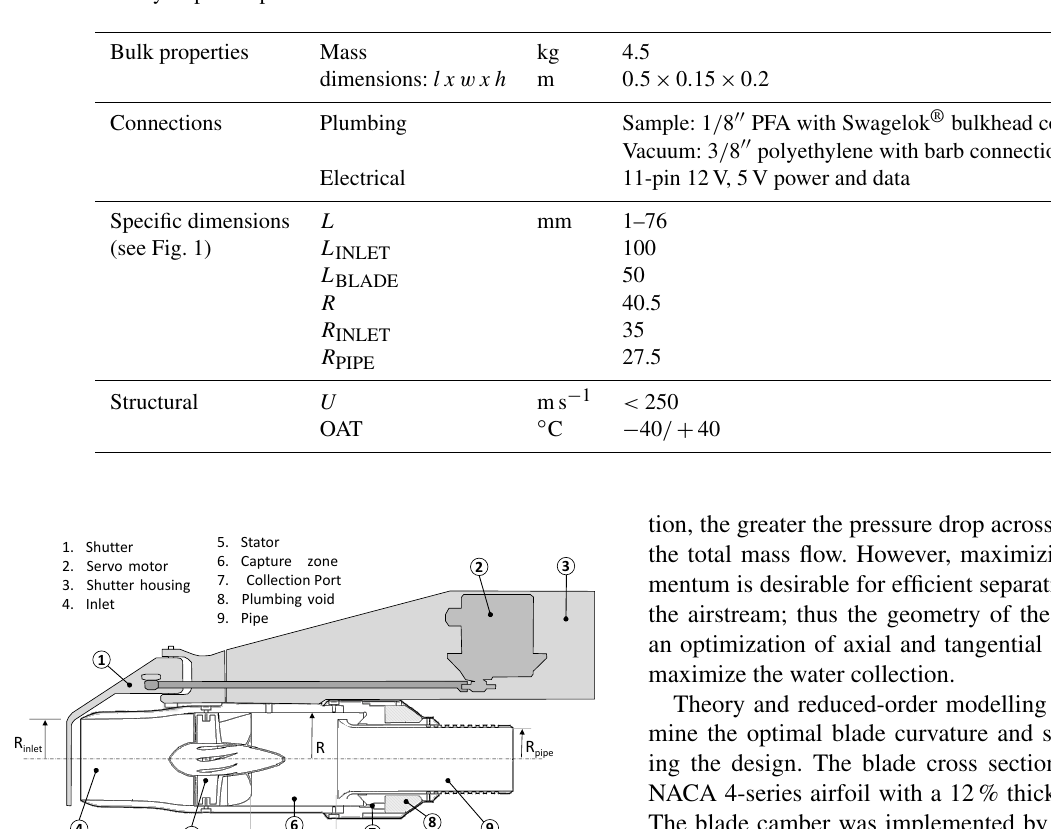
Table 1. Summary of probe specifications.